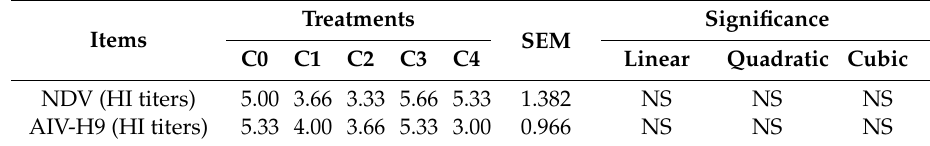
Table 4. E ff ect of chromium propionate on the immune response of the broilers.